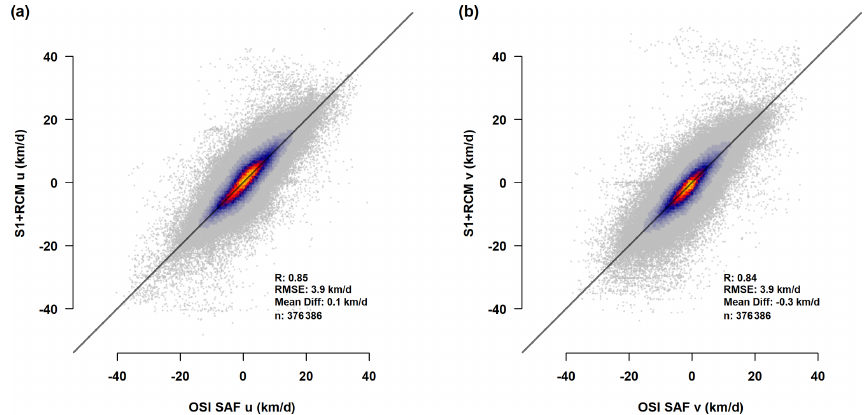
Figure 18. Heat scatterplots of S1 + RCM sea ice motion versus Ocean and Sea Ice Satellite Application Facility (OSI SAF) SIM for (a) u and (b) v vector components. Also shown is the number of samples ( n ), Pearson’s correlation coefficient ( R ), root-mean-square error (RMSE), and the mean difference